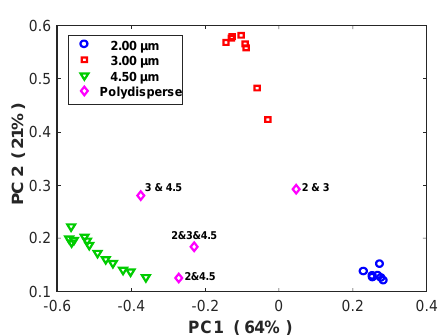
Fig. 3. PCA maps of mono- and polydisperse samples.